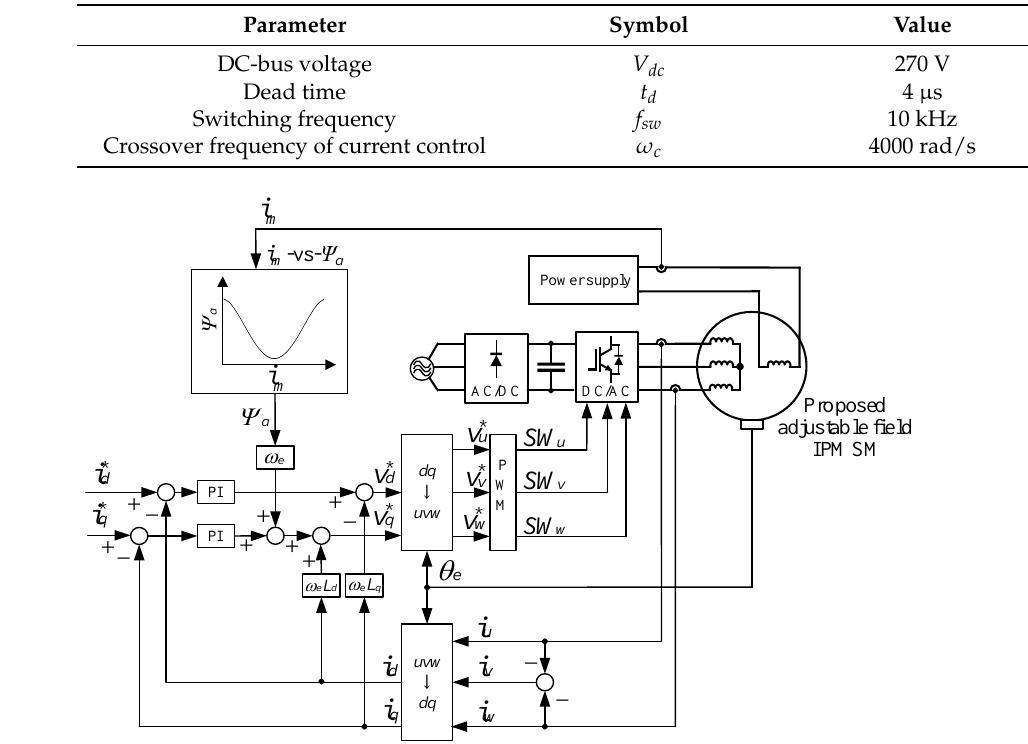
Figure 22. Control block diagram of current control of prototype motor when using DC i m . Figure 23 shows the experimental results at the rotating speed of 1000 r/min when an i m of 0 A or 6 A, an i d of 0 A and an i q of 20 A were given to the prototype motor. It can be confirmed from the waveforms of the three-phase line currents and i m that the line currents could be controlled regardless of the i m .